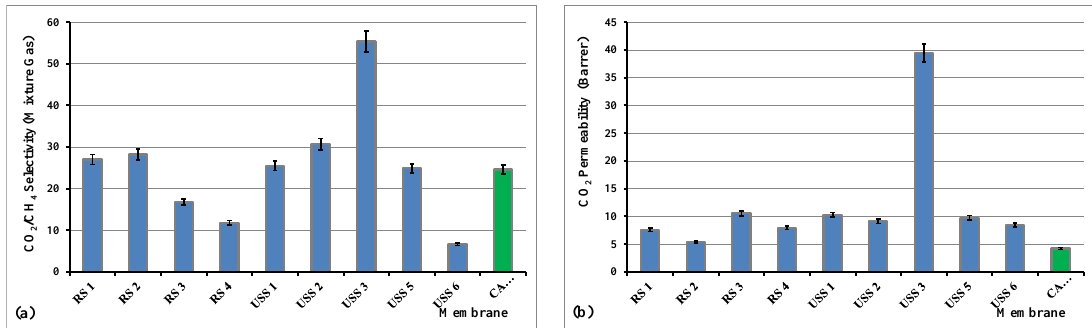
Figure 15. Selectivity of CO 2 /CH 4 gas mixture ( a ) and permeability of CO 2 , ( b ) at dP of 1.33 bar and 28 °C.